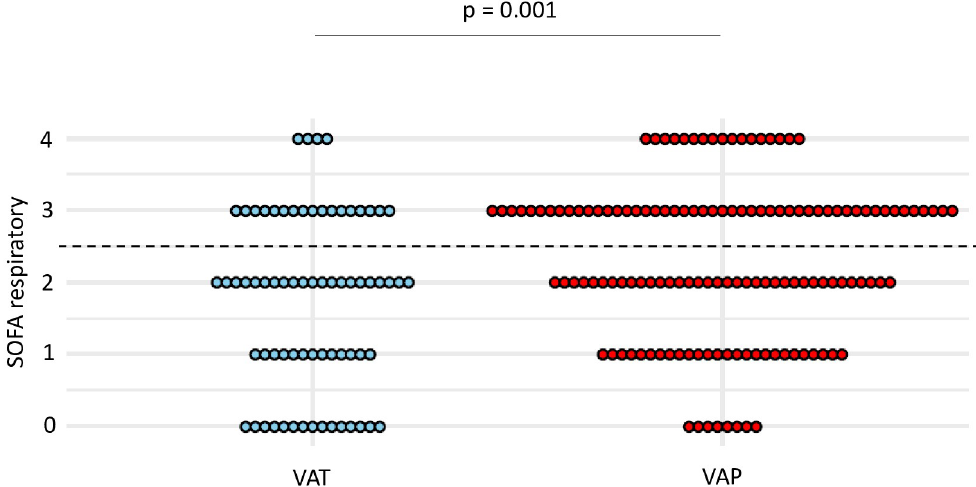
Fig 4. Dot plots of respiratory SOFA in patients with VAT and VAP. Values of respiratory SOFA, at VA-LRTI diagnosis, are shown as single dots for each patient. The dash line separates patients with a respiratory SOFA � 3 from those with a respiratory SOFA < 3, identified as the best cut-off according to the Youden index. SOFA sequential organ failure assessment; VAP ventilator-associated pneumonia; VAT ventilator-associated tracheobronchitis.